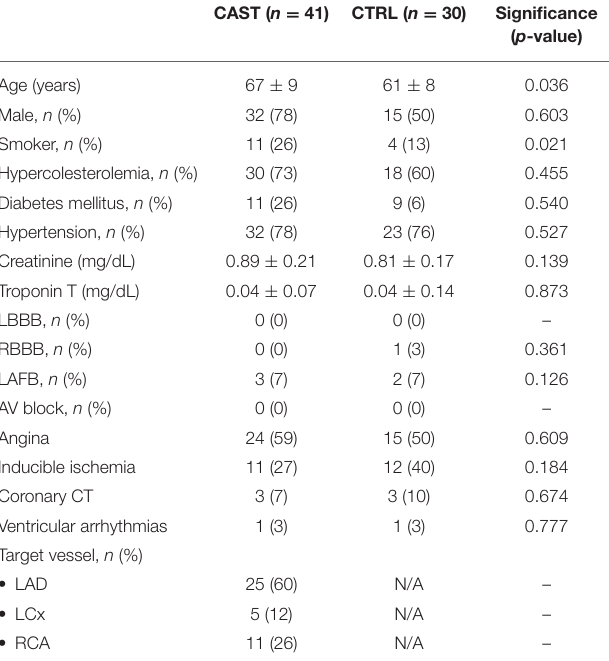
TABLE 1 | Baseline patients characteristics.